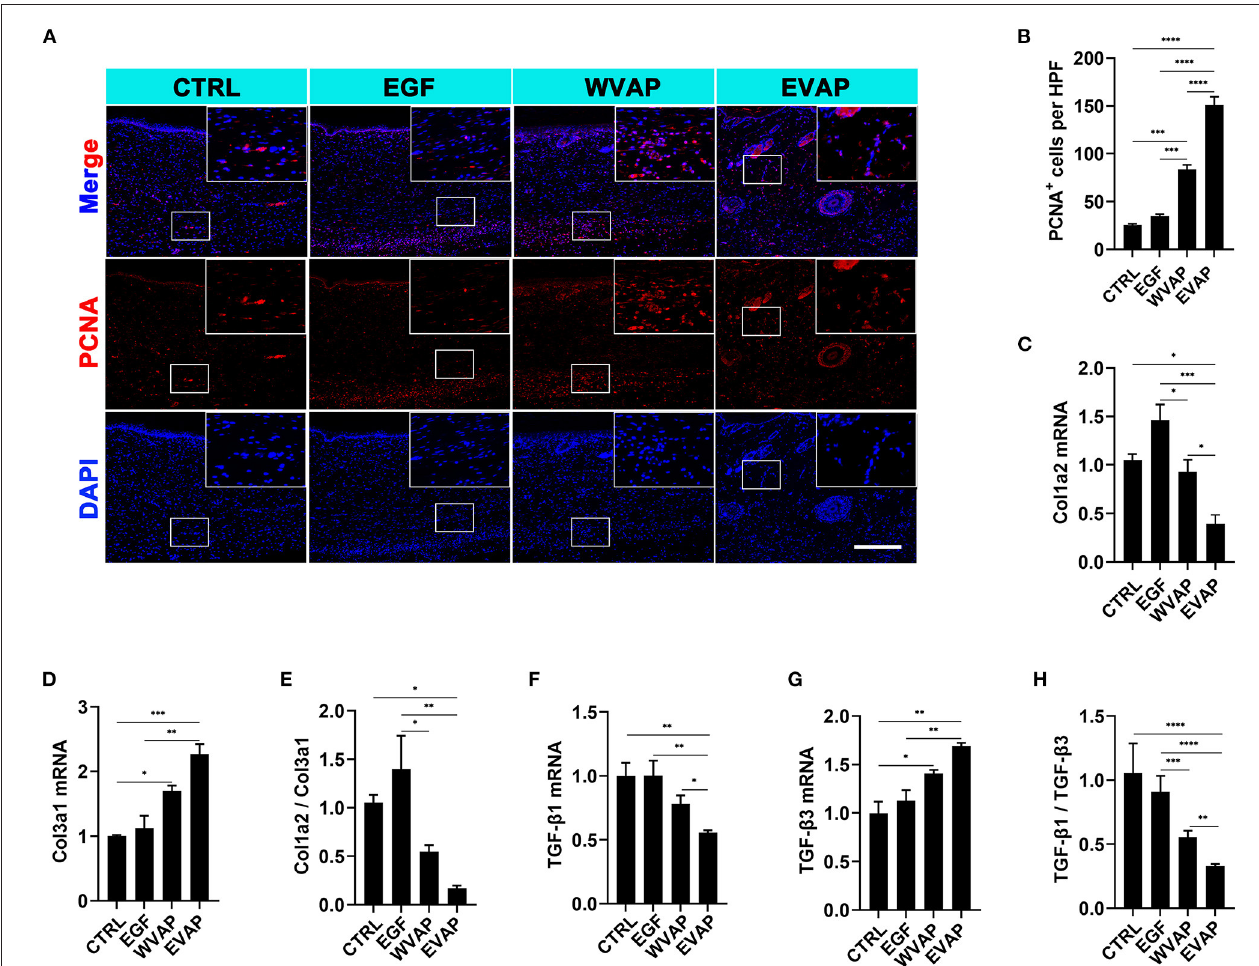
FIGURE 5 | Effects of EVAP on cell proliferation and the expression levels of scar-related genes of the healed tissue in model rats. (A) PCNA staining on the histological sections (scale bar = 300 µ m). (B) Quantification of PCNA + cells per HPF. Note that EVAP significantly increased the expression levels of PCNA compared to the controls. (C–H) mRNA expression levels of Col1a2, Col3a1, TGF- β 1, TGF- β 3, and ratios of Col1a2/Col3a1 and TGF- β 1/TGF- β 3 in the healed skin. Note that genes pro-scar formation (Col1a2 and TGF- β 1) were significantly down-regulated, whereas those anti-scar formation (Col3a1, TGF- β 3, MMP1, and MMP3) up-regulated. * P < 0.05; ** P < 0.01; *** P < 0.001; **** P < 0.0001; mean ± SD; n = 3. Col1a2, collagen type I α 2; Col3a1, collagen type III α 1; PCNA, proliferating cell nuclear antigen; TGF- β , transforming growth factor- β